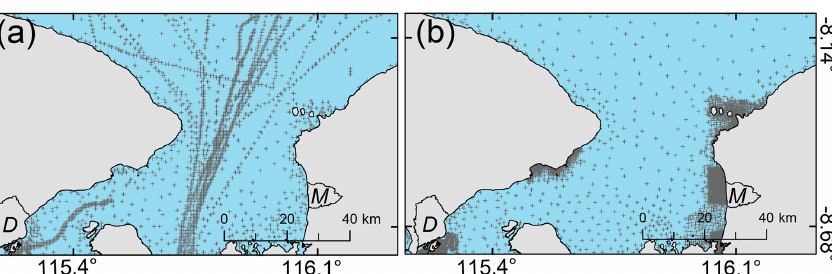
Figure 5. Comparison of the point density of water depth measurements from (a) GEBCO (direct measurements) and (b) nautical charts (soundings). GEBCO data are densest along the center of the Lombok Strait (following ship tracks), while the nautical chart soundings are concentrated near the coastal cities. Combining these data points enhances the accuracy of the resulting bathymetry (shown in Fig. 6). Crosses – locations of measurements. Polygons on land – cities of Denpasar, Bali, and Mataram, Lombok. D denotes Denpasar; M denotes